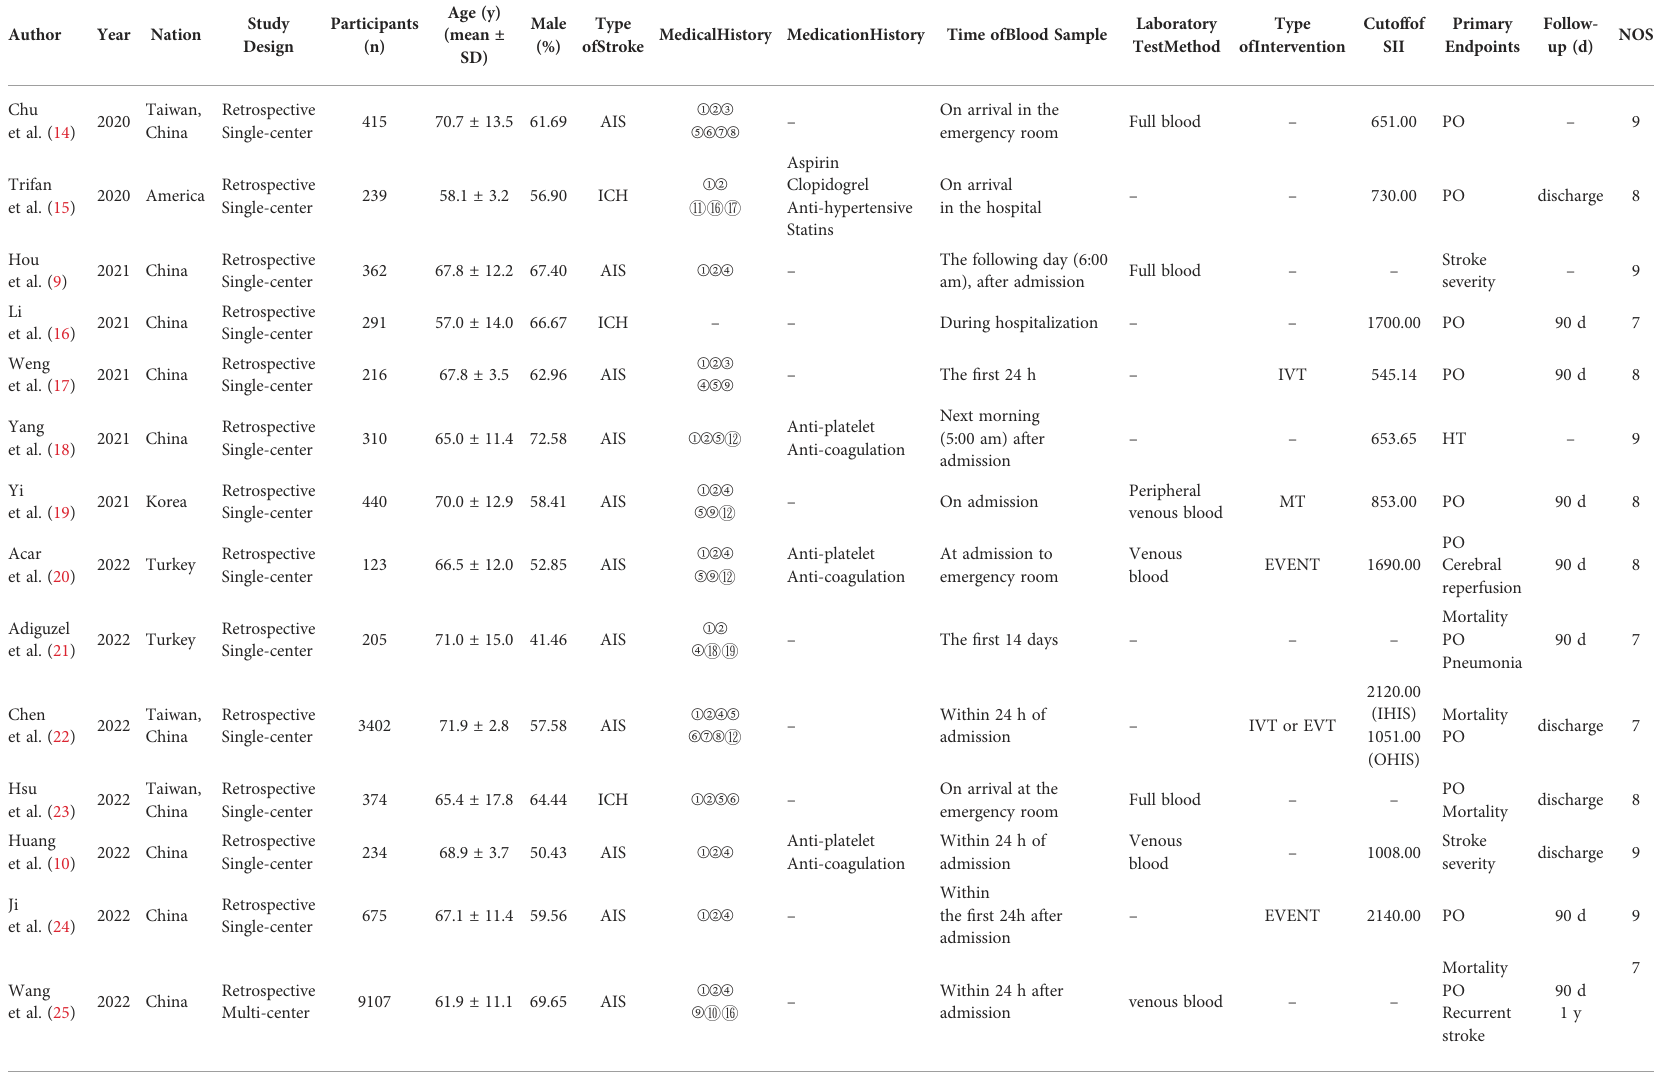
TABLE 1 The baseline characteristics of included